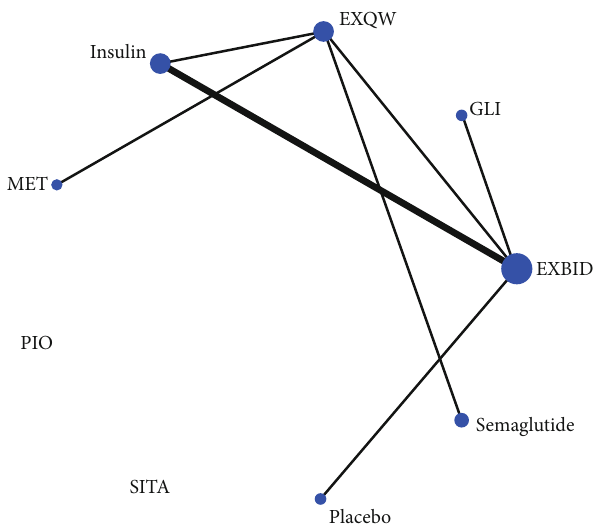
Figure 2: Evidence structure of eligible comparisons for network meta-analysis on HOMA- β